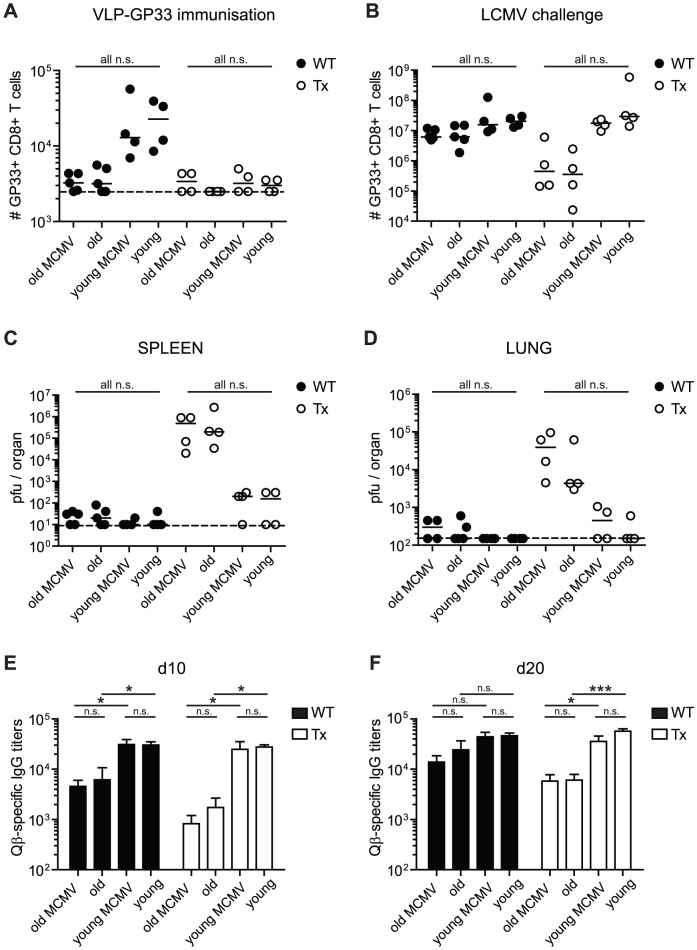
Immunogenicity and efficacy of VLP-immunisation against LCMV-challenge in young and old mice with/without Tx or latent MCMV-infection.Young (5 months old, 3 months p.i.) and old C57BL/6 mice (18 months old, 15 months p.i.) with or without Tx and latent MCMV-infection were immunised with 10 µg VLP-GP33 s.c. Thereafter, the GP33-specific CD8+ T cell response was measured on day 7 (A) by tetramer staining and the Qb-specific IgG titres were quantified by ELISA on day 10 (E) and day 20 (F) in the blood. On day 21, all mice were challenged with 2×103 pfu LCMV-WE i.v. Eight days after LCMV-challenge the GP33-specific CD8+ T cell response was determined by ICS in the lung (B) and LCMV-titres were determined in the spleen (C) and in the lung (D) by plaque assay. Circles indicate individual mice, horizontal lines represent the median (A–D). Vertical bars show the mean of an experimental group, error bars correspond to the SEM (E, F). The dotted line shows the detection limit of the assay. 4–5 mice per group were included. ANOVA followed by Bonferroni post-analysis was preformed to test for significant differences (* p<0.05; ** p<0.01; ns = not significant).